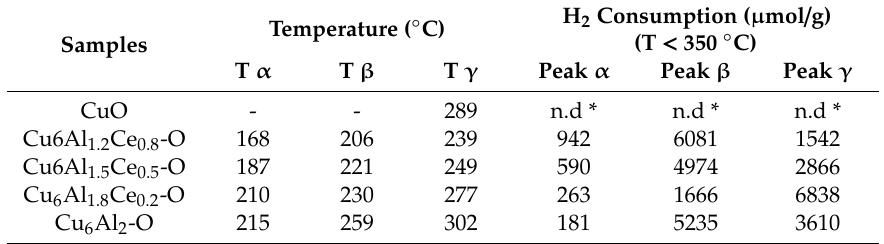
Figure 5. H 2 - temperature programmed reduction (TPR) profiles of CuO and Cu 6 Al 2-x Ce x -O samples.